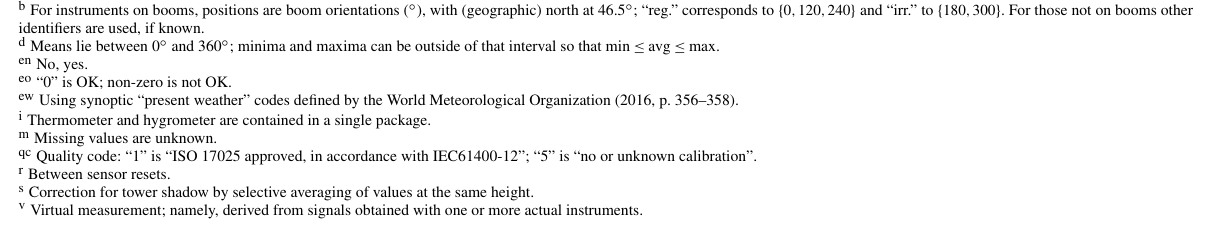
– precip. intensity 5 mmmin − 1 precip. amount 5,r mm 0– visibility 5 m From v,s cup anemometer (3) 27 , 58 . 5 , 92 hor. wind sp. 1 ms − 1 0.14 0.3–75 From v ultrasonic anemometer (3) 85 reg. wind sp. magn. 1 ms − 1 0.07 0–104 4 hor. wind sp. 1 ms − 1 0.07 0–85 From v,s ultrasonic anemometer (1) 85 hor. wind sp. 1 ms − 1 0.05 0–85 4 From v,s wind vane (3) 27 , 58 . 5 , 87 wind direction 1 ◦ 0.7 0–360 d 4 From v barom. and thermom. (2) 21 , 90 air density 1 kgm − 3 0.0001 0.5–2.0 4 b For instruments on booms, positions are boom orientations ( ◦ ), with (geographic) north at 46.5 ◦ ; “reg.” corresponds to { 0 , 120 , 240 } and “irr.” to { 180 , 300 } . For those not on booms other identifiers are used, if known. d Means lie between 0 ◦ and 360 ◦ ; minima and maxima can be outside of that interval so that min ≤ avg ≤ max. en No, yes. eo “0” is OK; non-zero is not OK. ew Using synoptic “present weather” codes defined by the World Meteorological Organization (2016, p. 356–358). i Thermometer and hygrometer are contained in a single package. m Missing values are unknown.